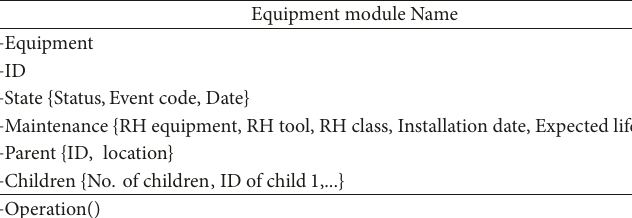
Figure 3: Equipment module using UML class.